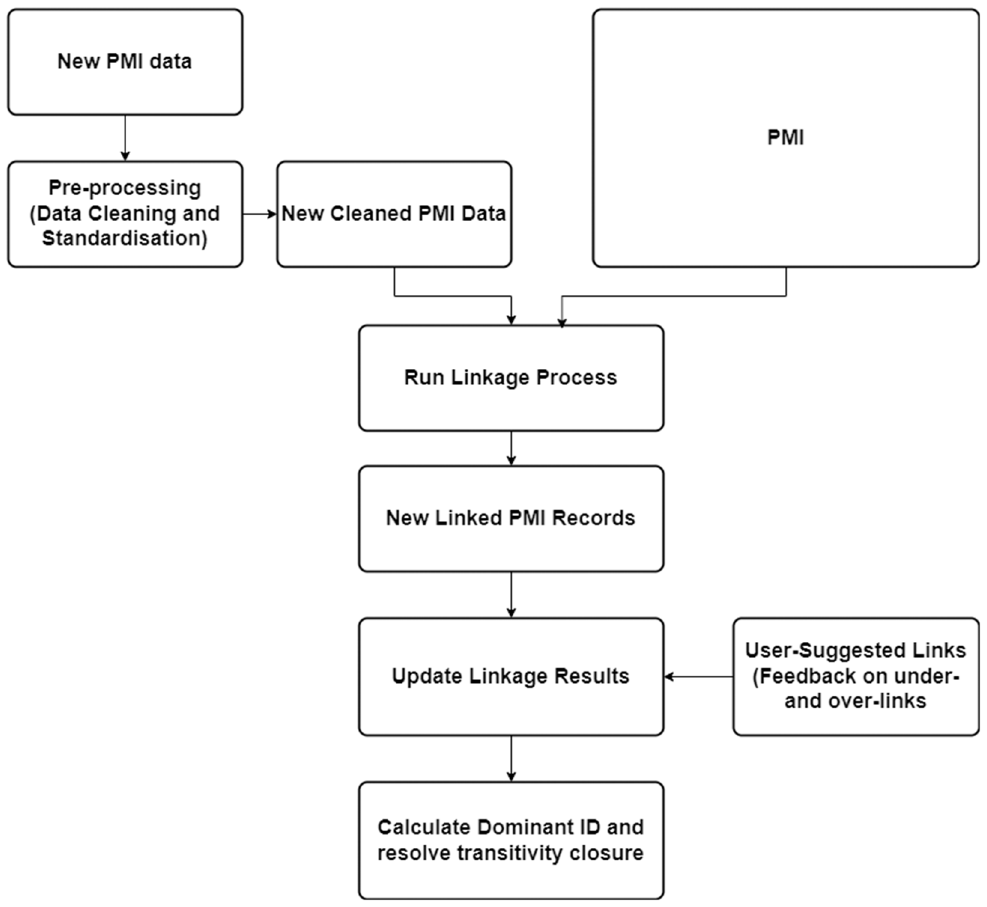
Figure 2: Overview of the PHDC PMI linkage